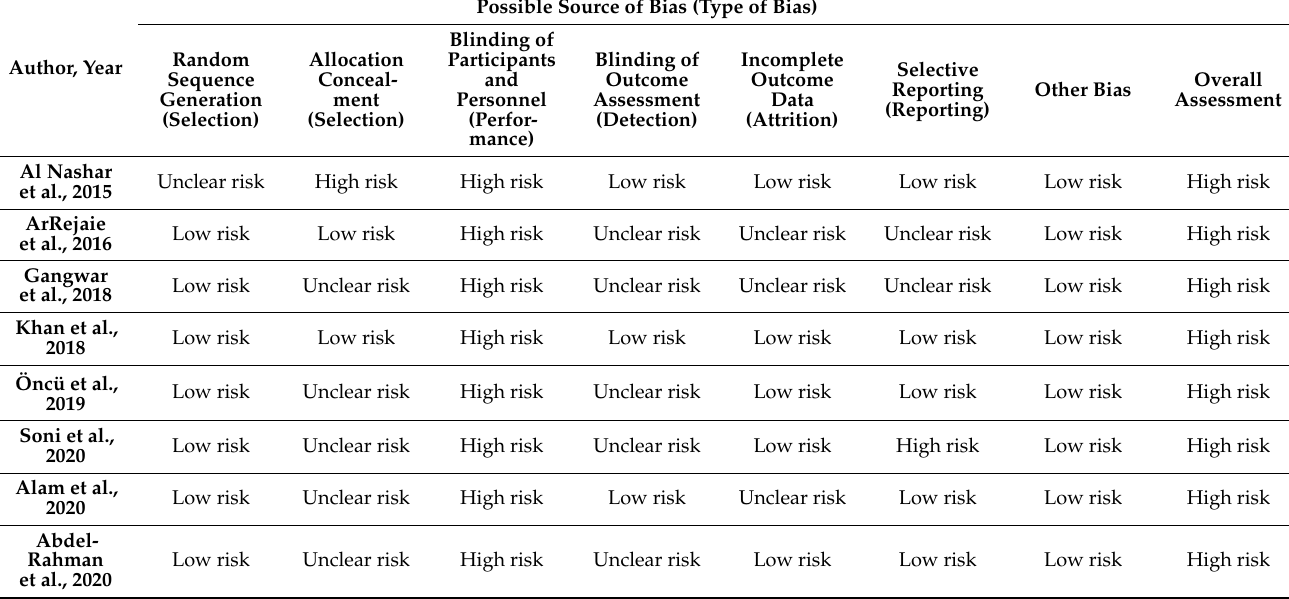
Table 5. Risk-of-bias assessment of the controlled clinical trials